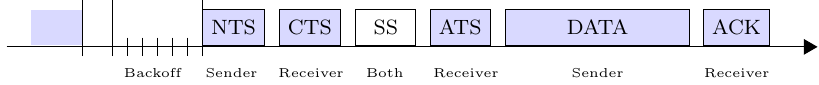
Figure 3. Typical packet transmission procedure under Handshake Sense Multiple Access with Collision Avoidance (HSMA/CA). NTS, Notify to Sense; CTS, Clear to Sense; SS, Spectrum Sensing; ATS, Acknowledge to Sense; ACK,